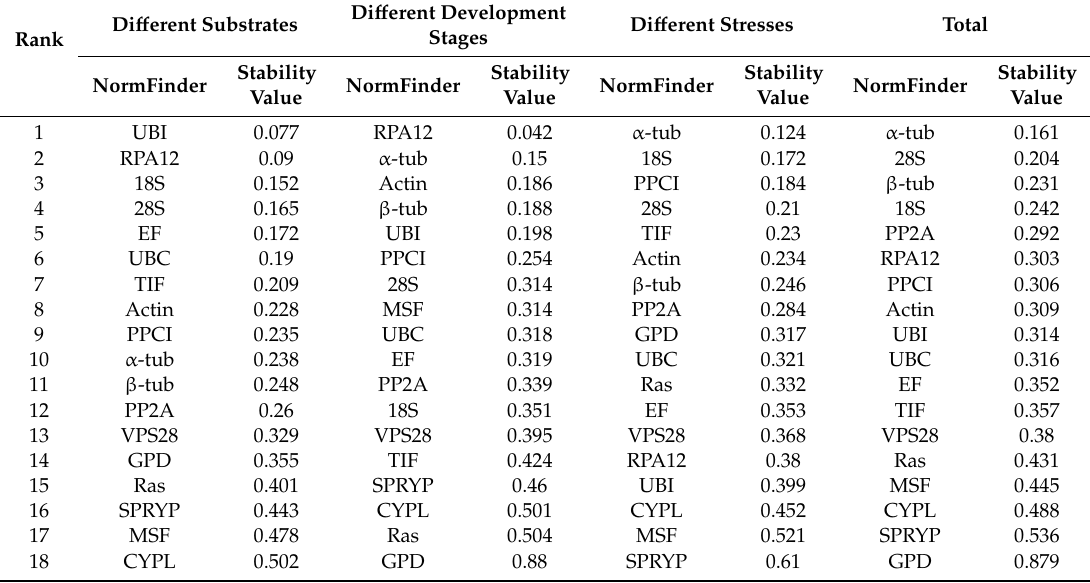
Table 2. Stability analysis of eighteen candidate reference genes by